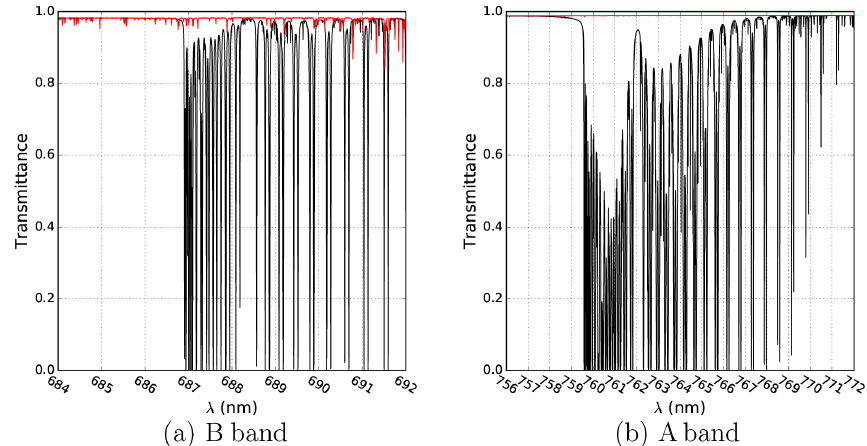
Figure 3. Line-by-line transmittances in the oxygen A (b) and B (a) bands (black lines). The transmittances of the overlapping water vapour lines are represented in red. The calculations are computed using the HITRAN2016 database (Gordon et al., 2017) for a solar zenith angle of 0 ◦ .